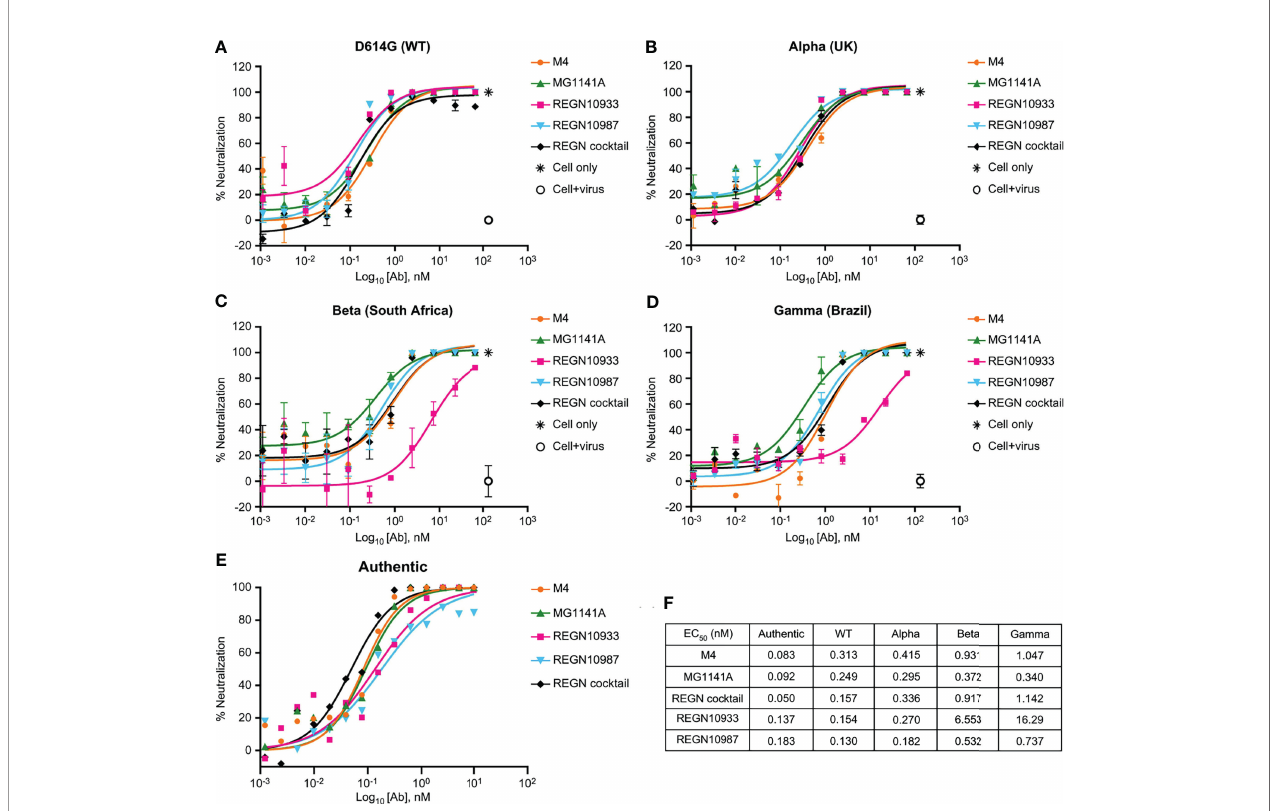
FIGURE 3 | Neutralizing activity of anti-SARS-CoV-2 mAbs. (A – D) Dose-dependent neutralization of SARS-CoV-2 pseudovirus of D614G (wild type), Alpha (United Kingdom), Beta (South Africa), and Gamma (Brazil). Neutralizing activities of 11-point – diluted anti-SARS-CoV-2 mAbs were evaluated on ACE2-HEK293 cells using the luciferase assay system. The EC 50 and EC 90 values were determined by curve fi tting with non-linear regression analysis (sigmoidal dose response). Bars, mean ± standard error of the mean (SEM) of triplicates derived from one of the two experiments. (E) Dose-dependent neutralization of SARS-CoV-2 isolated from a patient (Korea/KUMC45/2020, GH clade) by mAbs, as evaluated by a plaque reduction neutralization test on Vero cells. One representative out of three experiments with similar results is shown. (F) The EC 50 values of the in vitro neutralizing assay against variant